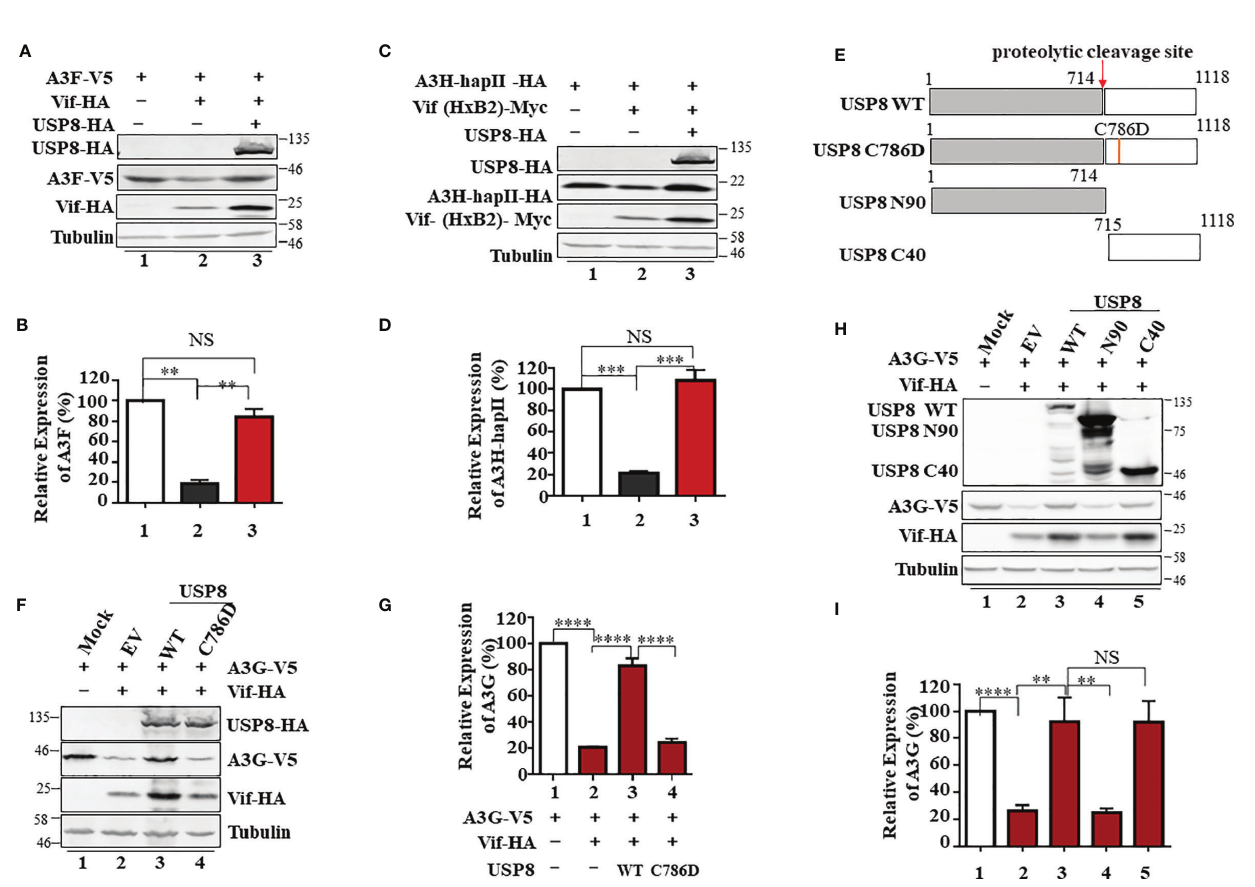
FIGURE 2 | The active site of ubiquitin-speci fi c protease 8 (USP8) is required for inhibition of HIV-1 virion infectivity factor (Vif) function. USP8 ef fi ciently inhibited HIV- 1 Vif-induced apolipoprotein B mRNA-editing enzyme catalytic polypeptide-like 3 (APOBEC3)F (A3F) (A) and A3H-HapII (C) degradation. (A, C) HEK293T cells were co-transfected with expression vector as indicated. Cells were harvested 48 h after transfection. Protein expression in the cell lysates was analyzed by immunoblotting with the corresponding antibodies. Tubulin was used as a loading control. (B, D) Quanti fi cation of A3F or A3H-HapII expression was analyzed by ImageJ2X. A3F (B) or A3H-HapII (D) expression alone was normalized to 100%. (E) The schematic represents USP8 wild type (WT) and mutations used in the study. The red arrow shows the USP8 proteolytic cleavage site (p.714Arg). (F) The USP8C786D mutation has lost the ability to inhibit Vif-mediated degradation of A3G. HEK293T cells were transfected with A3G-V5 alone or together with Vif-HA in the presence of USP8 WT-HA, the USP8C786D-HA mutation, or empty vector (EV). Cells were harvested 48 h after transfection, and protein expression in the cell lysates was analyzed by immunoblotting with anti-V5 and anti-HA antibodies targeting A3G-V5, USP8-HA, and Vif-HA protein. Tubulin was used as a loading control. (G) Quanti fi cation of A3G expression was analyzed by ImageJ2X. A3G expression alone was normalized to 100%. (H) HEK293T cells were transfected with A3G-V5 alone or together with Vif-HA in the presence of USP8 WT-HA, a